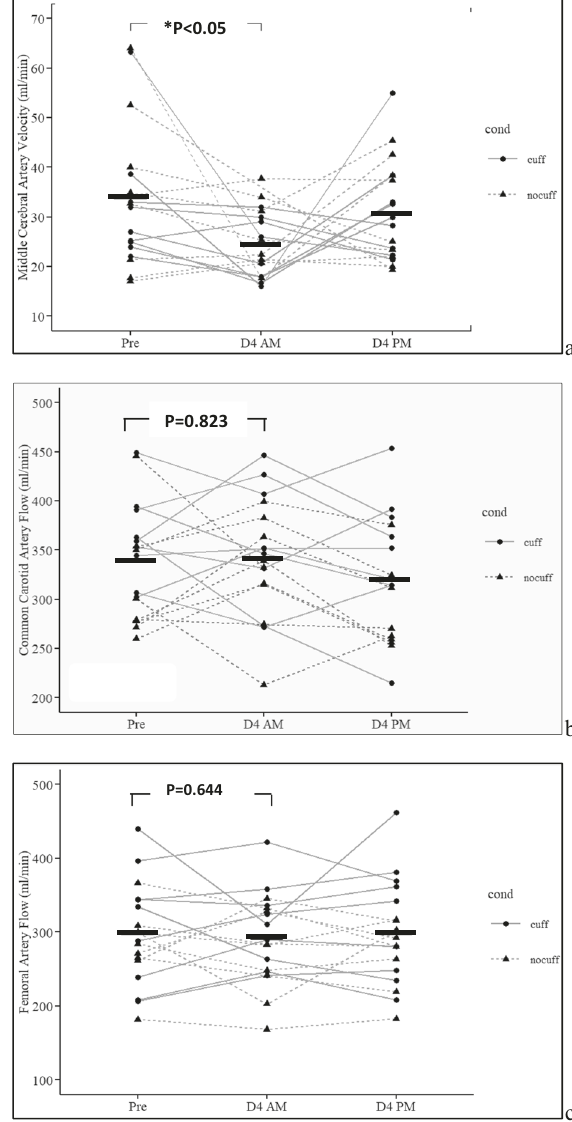
Fig. 2 Arterial wall properties after 4 days of dry immersion. Horizontal black bars represent the mean. DI effect from Pre to D4 AM on the 2 gr averaged (* p ) is reported as “ * p < 0.0 x ” and plotted on top of the diagram. The change from D4 AM to D4 PM (with or without cuffs) are not signi fi cant for any parameter ( p not reported). Pre was prior to dry immersion; D4 AM represents 4 days of dry immersion (morning prior to donning cuffs for the day for the cuff gr). D4 PM represent the data in the afternoon of day 4, after 10 h with cuff on, for the cuff gr.